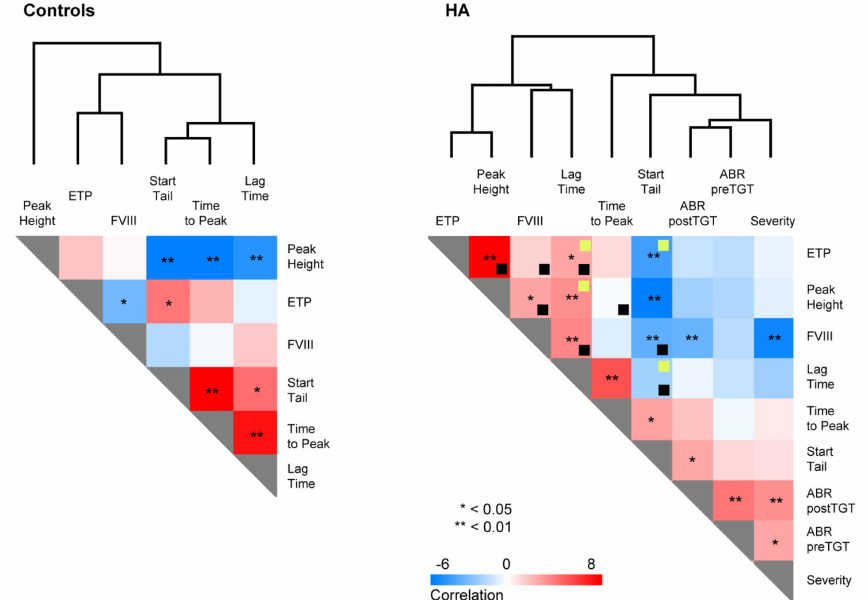
Figure 4. Correlation of TGT and clinical parameters. Correlation analysis of FVIII activity levels and TGT parameters in control subjects (left) and correlation analysis of FVIII activity, annual bleeding rates (ABR, preTGT, and postTGT), severity, and TGT parameters in HA patients (right). Grades of blue represent inverse correlation and grades of red represent direct correlation. The level of significance is indicated with asterisks (Spearman correlation, bilateral significance). Black squares indicate a change of significance (significant–not significant) as observed in control correlations, and the yellow squares indicate a change in the sign of the correlation